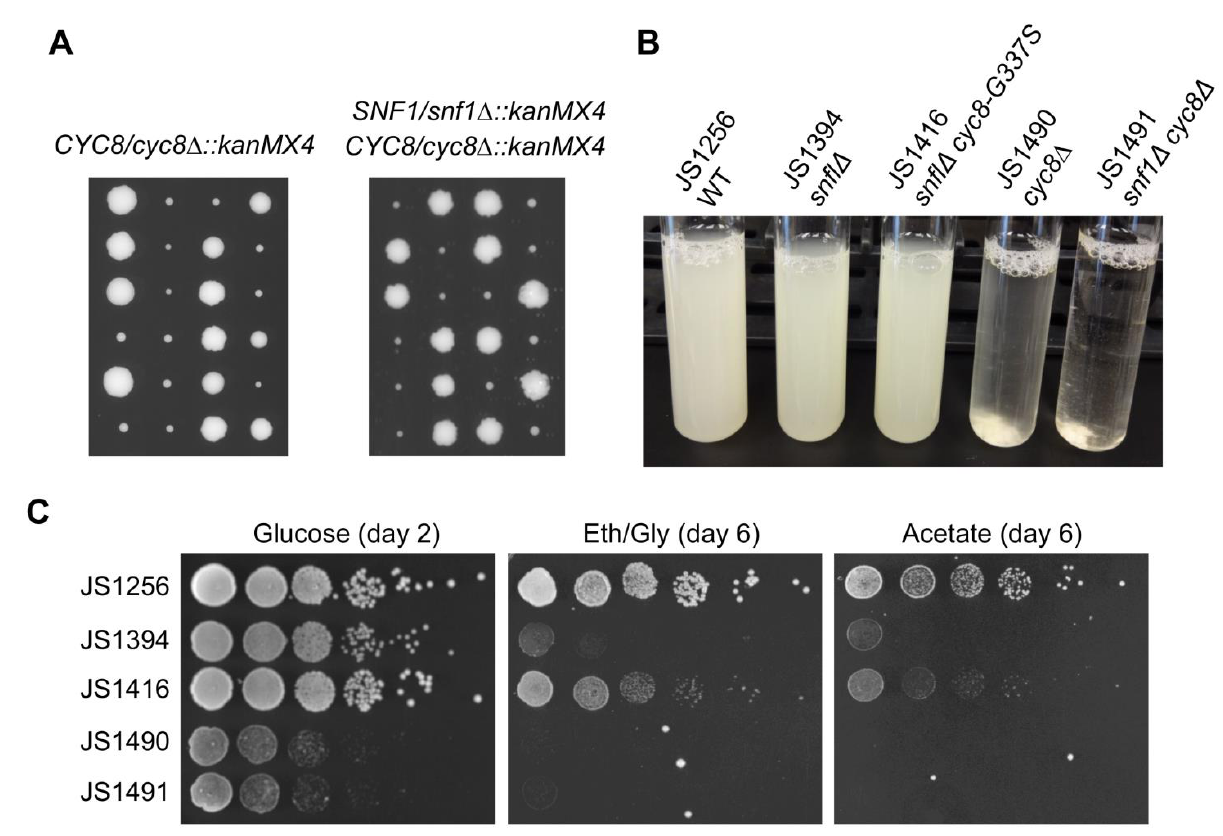
FIGURE 4: Distinct phenotypic differences between adaptation-derived cyc8 mutants and cyc8 ∆ mutants. (A) Growth of spores from tet- rad dissection of CYC8/cyc8 ∆ ::kanMX4 or SNF1/snf1 ∆ ::kanMX4 CYC8/cyc8 ∆ ::kanMX4 heterozygous diploids. Spores were dissected onto YPD plates and grown for 5 days. (B) Flocculence phenotype of strains deleted for CYC8 compared to a representative adapted mutants from the screen ( cyc8-G337S ). Cultures were grown for 2 days on a roller drum, then briefly vortexed and allowed to settle for 5 min. (C) Spot test growth assay comparison of snf1 ∆ (JS1416) suppression phenotype compared to the snf1 ∆ cyc8 ∆ mutant (JS1491), which grows very poorly. A cyc8 ∆ mutant (JS1490) also grows